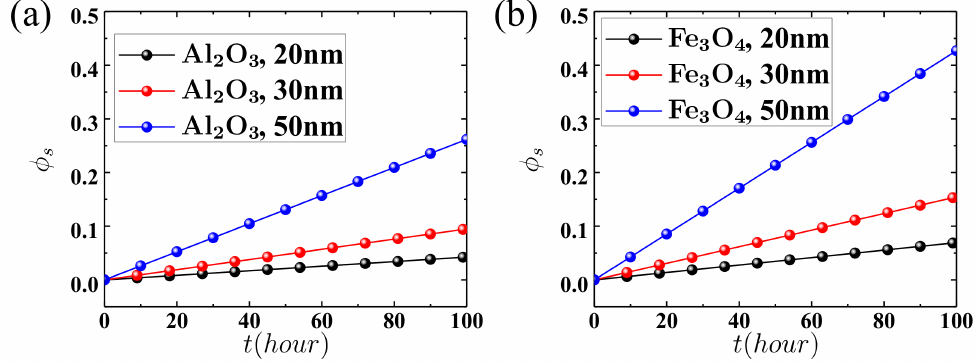
Figure 5. Effect of the nanoparticle size and type on nanoparticle accumulation, φ s . ( a ) Al 2 O 3 and ( b ) Fe 3 O 4 nanoparticle accumulation ( φ s ) as a function of time for different sizes.